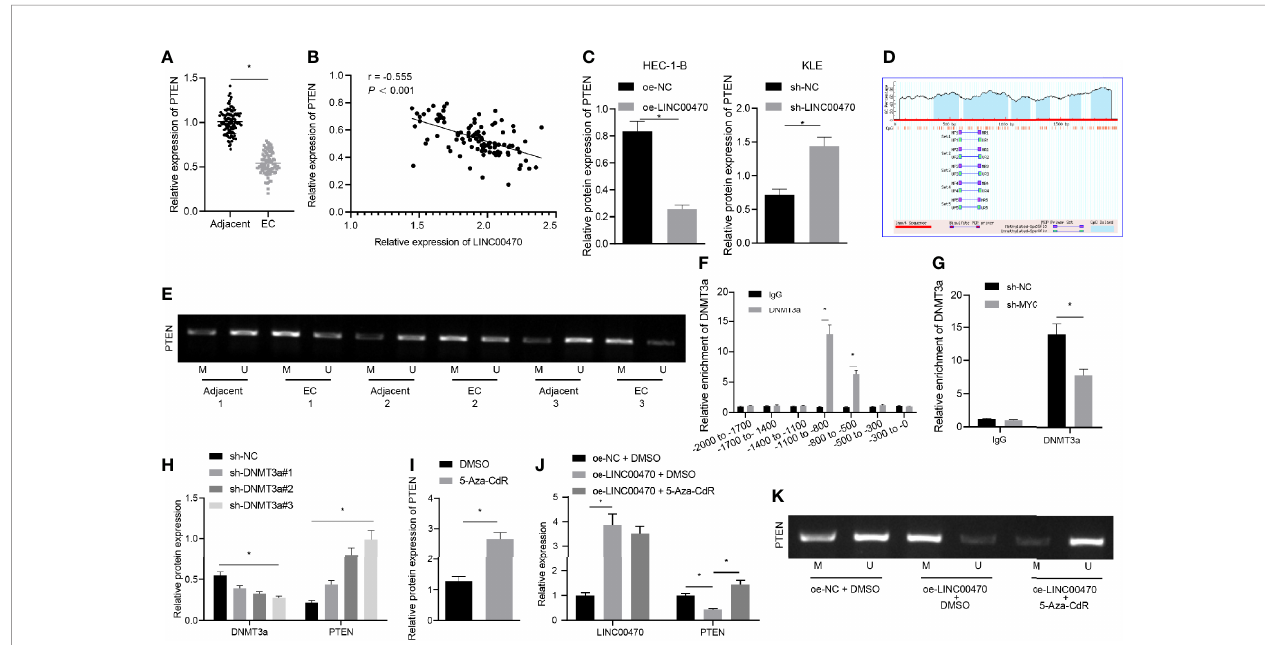
FIGURE 5 | LINC00470 recruited DNMT3a through MYC to stimulate PTEN methylation and down-regulate PTEN expression. (A) RT-qPCR determination of PTEN expression in 103 EC tissues and 70 normal control tissues. (B) Correlation analysis between LINC00470 and PTEN in EC. (C) Western blot analysis of PTEN expression in HEC-1-B and KLE cells after oe-LINC00470 or sh-LINC00470 treatment normalized to b -actin. (D) Rich CpG islands in gene promoters predicted by Methprimer (http//www.urogene.org/cgi-bin/methprimer/methprimer.cgi). (E) MSP determination of the methylation status of PTEN in EC tissues, wherein U means non-methylation and M means methylation. (F) The binding position of DNMT3a in the PTEN promoter region assessed by ChIP. (G) Changes of DNMT3a in PTEN gene promoter region after sh-MYC treatment detected by ChIP. (H) Western blot analysis of the expression of DNMT3a and PTEN in the cells after sh-DNMT3a-1, sh-DNMT3a-2, or sh-DNMT3a-3 treatment normalized to b -actin. (I) Western blot analysis of the expression of PTEN in the cells after 5-Aza-CdR treatment normalized to b -actin. (J) RT-qPCR measurement of LINC00470 and PTEN in HEC-1-B cells after oe-LINC00470 or 5-Aza-CdR treatment. (K) MSP assessment of the methylation status of PTEN in the methylation status of PTEN after oe-LINC00470 or 5-Aza-CdR treatment. The experimental data were expressed as mean ± standard deviation, and the comparison between two groups was performed using independent sample t-